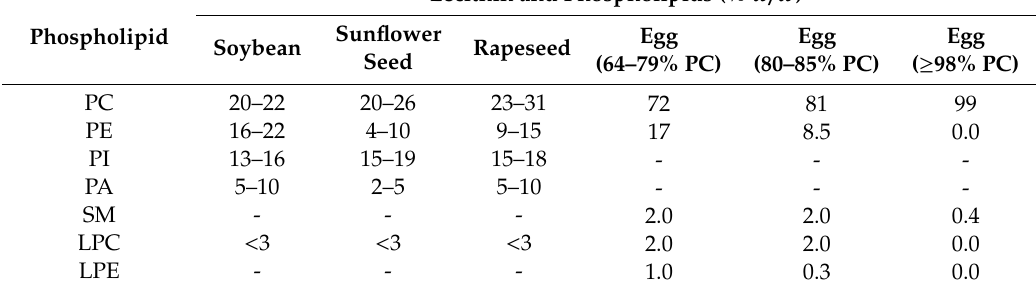
Table 1. Phospholipid composition of vegetable de-oiled lecithins (derived from product specifications [16]) and egg phospholipids of di ff erent PC contents (after extraction and chromatography [17]), respectively. Data taken from [9].